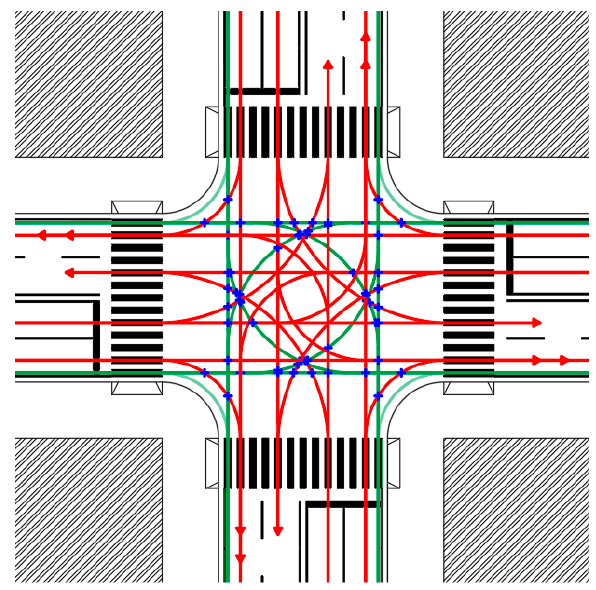
Figure 3. Trajectory diagram of bikes in a four-arm junction.